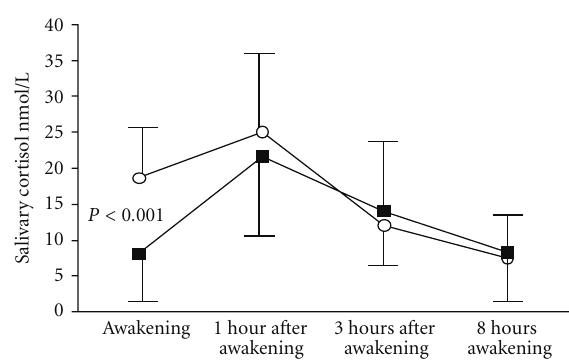
Figure 1: Salivary cortisol profile after awakening (AW) among Finnish media workers with irregular shift work ( N = 65, (cid:2) ) and regular daytime work ( N = 66, ◦ ). P value for awakening